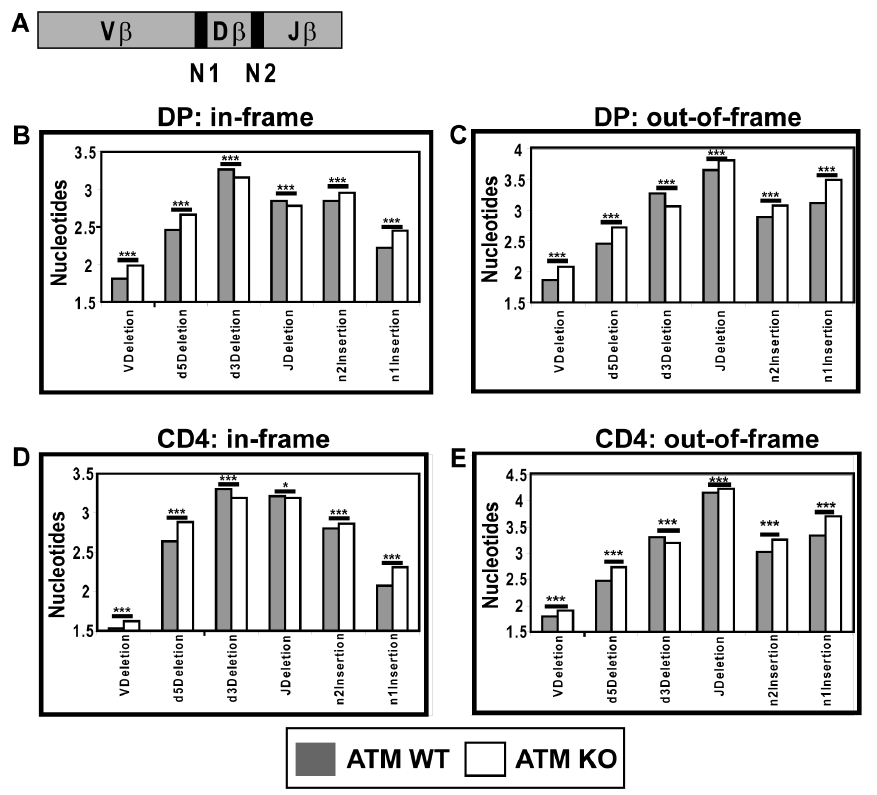
Figure 2. ATM deficiency alters in-frame and out-of-frame junctional sequences of TCR b CDR3 in pre- and post-selection T cells. (A) Diagram of TCR b CDR3 junctions. Nucleotide deletions and additions were sequenced from in-frame and out-of-frame TCR b CDR3 regions isolated from ATMWT (grey bars) or KO (white bars) cells that were either TCR a KO DP thymocytes (B and C) or naı¨ve CD4 + T cells (D and E). TCR a KO DP and naı¨ve CD4 + T cells were sorted from two mice of each ATM genotype. Each data point represents . 55,000 sequences. P values were calculated using Student’s unpaired 2-tailed t-test. *p , 0.05; **p , 0.01; ***p , 0.001.